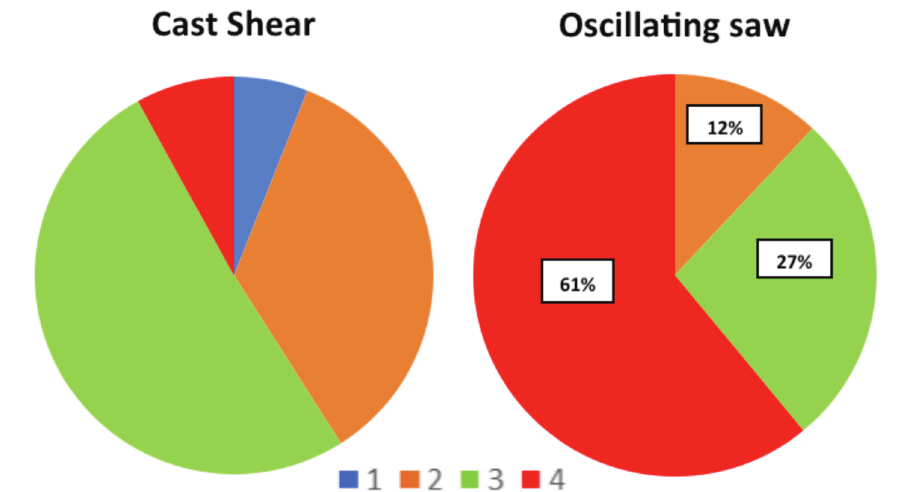
Comparison of Children’s Fear Scale in cast shear and oscillating saw group. Score 1 to 4, represented by the respective colours. Fig. 3: Number of patients expressed in percentages